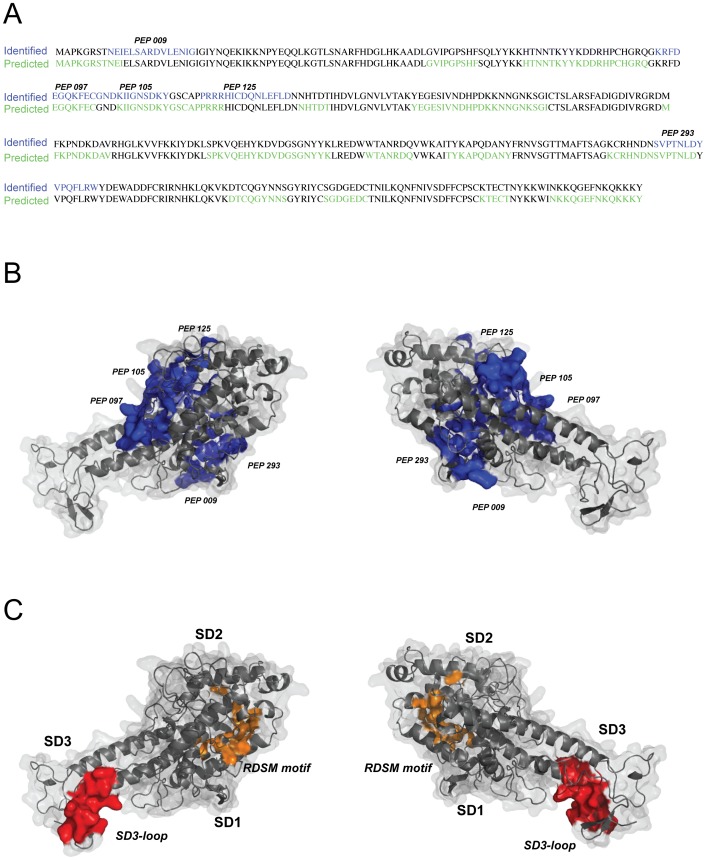
Localization of epitopes targeted by rosette disruptive on the NTS-DBL1αIt4var60 domain.A) Comparison between predicted epitopes (predicted, in green) and epitopes correlated with rosette disruption ability (identified, in blue). Prediction of the localization of B-cell epitopes for the NTS-DBL1αIt4var60 domain was carried out and epitopes predicted to be surface exposed are marked in green. Epitopes that correlated with the ability to disrupt rosettes are marked in blue. B) A model of the NTS-DBL1αIt4var60 domain was generated based on the NTS-DBL1αPAvarO crystal structure [18]. The mapped peptides targeted by antibodies that disrupted rosettes on FCR3S1.2 iRBC are highlighted in blue in the model. C) For comparison, the localization SD3-loop, previously identified as target of rosette disruptive antibodies (12) is highlighted in red and the RDSM motif, shown to induce strain-transcending antibodies [32], in orange.